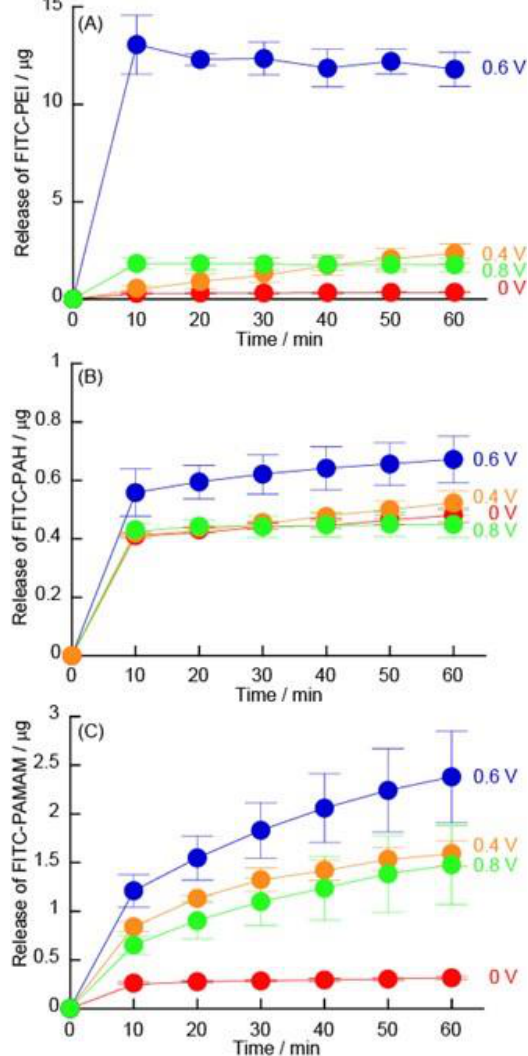
Figure 12. Release of ( A ) FITC-PEI from (FITC-PEI/TEMPO-PAA) 5 , ( B ) FITC-PAH from (FITC- PAH/TEMPO-PAA) 5 film, and ( C ) FITC-PAMAM from (FITC-PAMAM/TEMPO-PAA) 5 films coated on GCE at different constant potentials (red: 0 V, orange: +0.4 V, blue: +0.6 V, and green: +0.8 V).